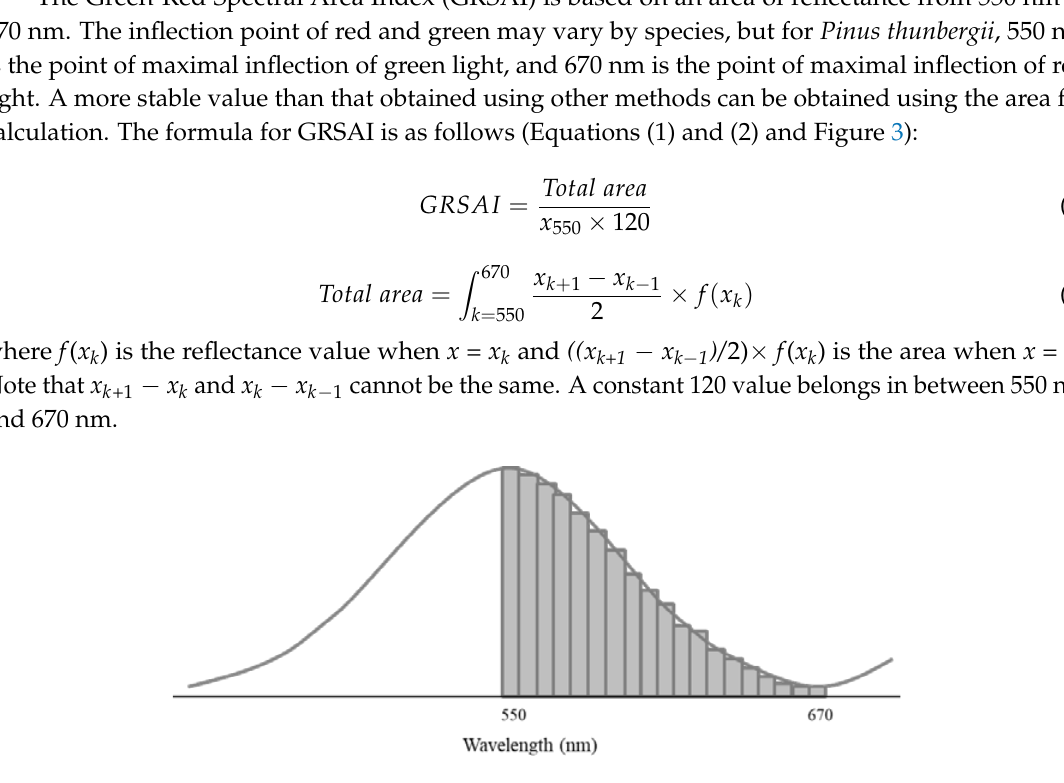
Figure 3. The green-red spectral area index (GRSAI) calculation utilizing integration.